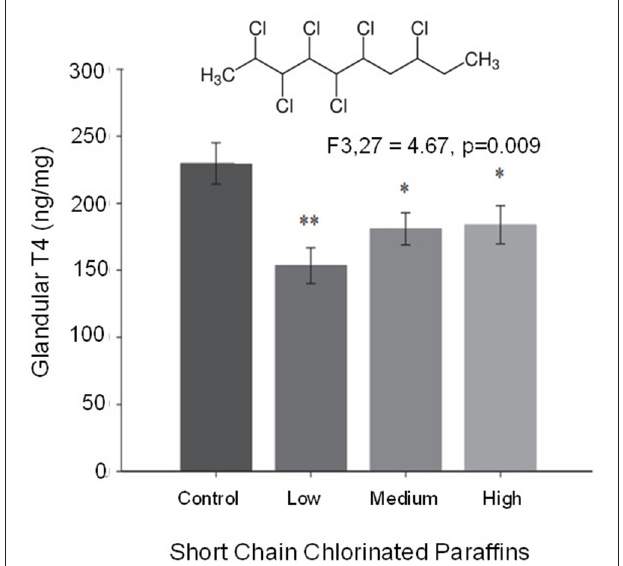
FIGURE 7 | Thyroid gland concentrations of T4 from hatchling American kestrels exposed to a range of concentrations of short chain chlorinated paraffins. These compounds, an example of which is shown at the top of the graph, act as endocrine disruptors affecting thyroid function. The widely used short chain chlorinated paraffins and their high environmental prevalence constitute a threat for fauna and humans alike that could be monitored through raptors (modified from Fernie et al., 2020). *Statistically significant different group 1. **Statistically significant different group